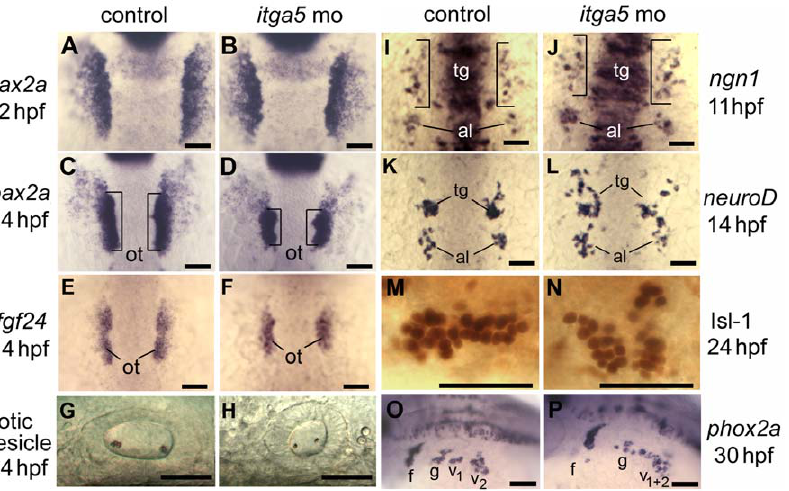
Figure 1. Knockdown of itga5 impairs morphogenesis of posterior cranial placodes. ( A–D ) pax2a expression at 12 and 14 hpf in the otic/ epibranchial domain in control embryos (A, C) and itga5 morphants (B, D). Expression is normal at 12 hpf in itga5 morphants but the otic placode (o, brackets) is smaller than normal by 14 hpf. ( E, F ) fgf24 expression at 14 hpf in a control embryo (E) and itga5 morphant (F). ( G, H ) Otic vesicles at 24hpf in a control embryo (G) and itga5 morphant (H). ( I, J ) ngn1 expression at 11 hpf in a control embryo (I) and itga5 morphant (J). ( K, L ) neuroD expression at 14 hpf in a control embryo (K) and itga5 morphant (L). Precursors of the trigeminal ganglion (tg) and anterior lateral line (al) are indicated. ( M, N ) Anti-Isl-1 immunostaining at 24 hpf in a control embryo (M) and itga5 morphant (N). ( O, P ) phox2a expression in epibranchial ganglia at 30 hpf in a control embryo (O) and itga5 morphant (P). Facial (f), glossopharyngeal (g), and vagal ganglia (v1 + v2) are indicated. A–E, I–K are dorsal views with anterior to the top; G, H, M–P are lateral views with anterior to the left. Scale bar, 50 m